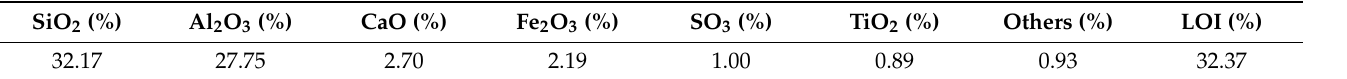
Table 2. Main chemical composition of the KAS.